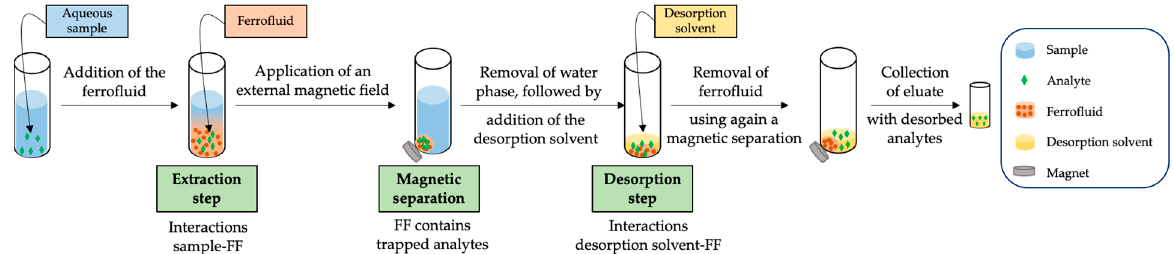
Figure 1. General scheme of the most common operational procedure followed in ferrofluid (FF)-based analytical extraction methods.